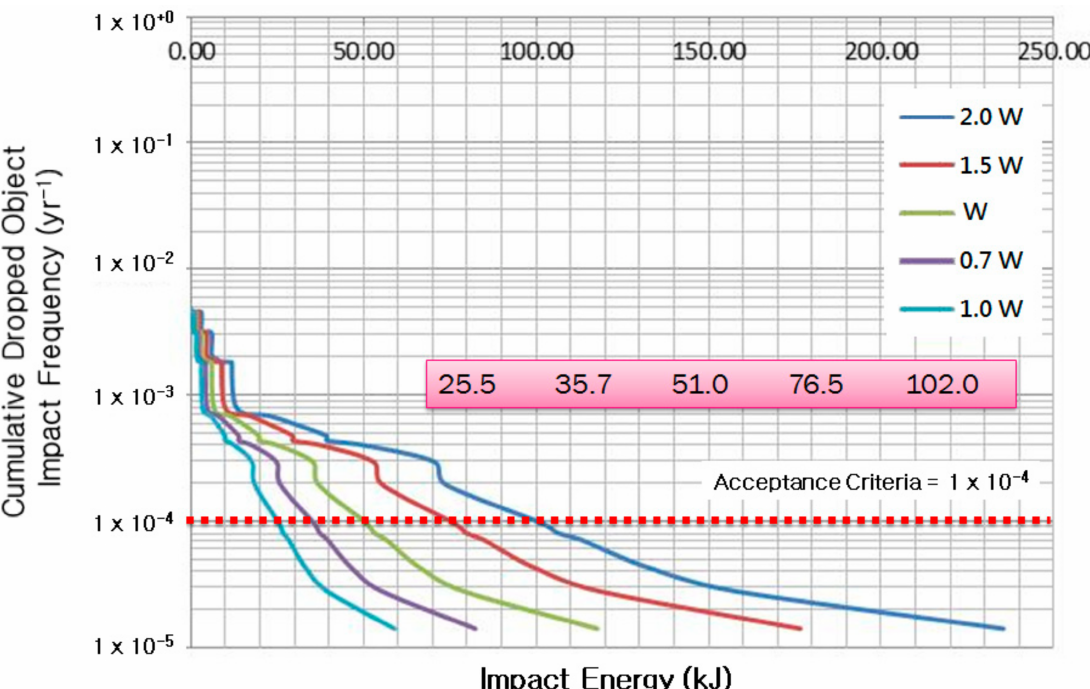
Figure 9. Impact energy exceedance curve by drop